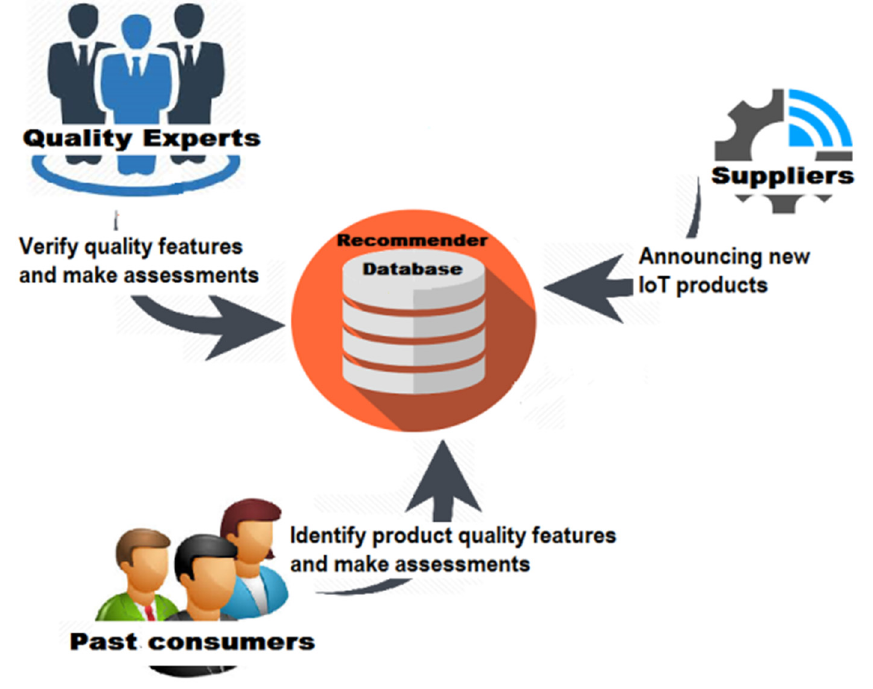
Figure 2. The establishment and assessment phase.